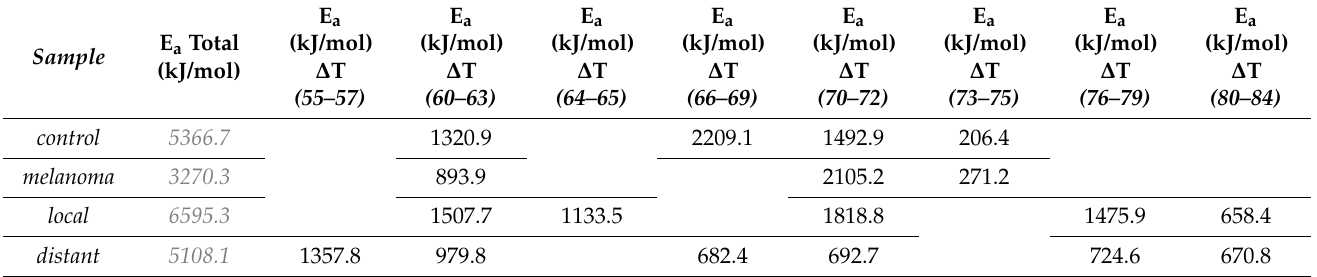
Table 8. Contribution of activation energies (gray numbers) resulted by the analysis of deconvolved data from Figure 4 in the different temperature ranges of the peaks ( ∆ T). (The empty fields indicating missing data as the fitting does not work properly with small peaks, thus cannot result applicable values, recently